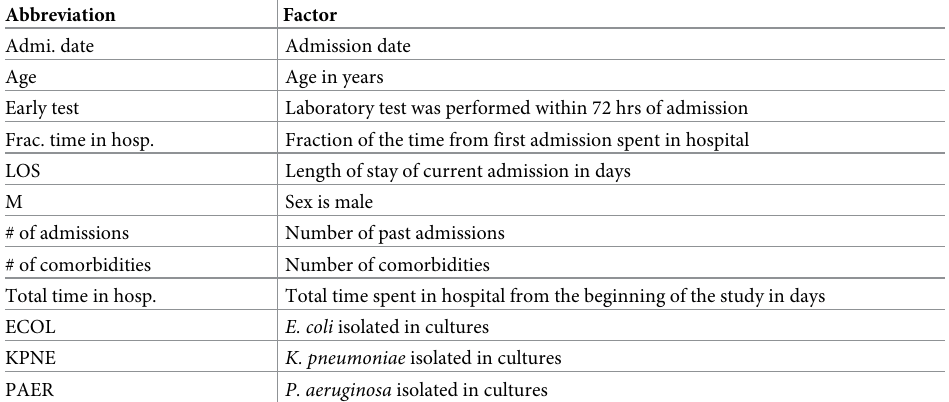
Table 3. Key covariates included in the GBDT classifier in addition to those of Table 2 and Tables A-B in S1 Text, and their